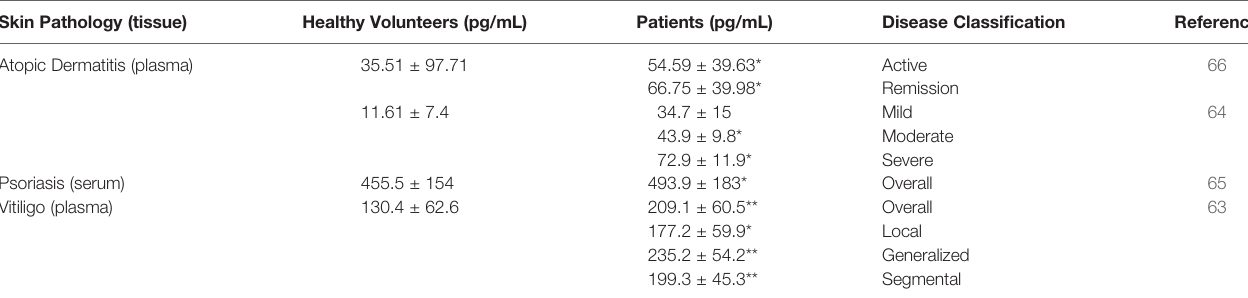
NPY is signi fi cantly elevated in the circulation of patients with AD and vitiligo, but not psoriasis. Data are shown as mean ± standard deviation. *p < 0.05. **p <